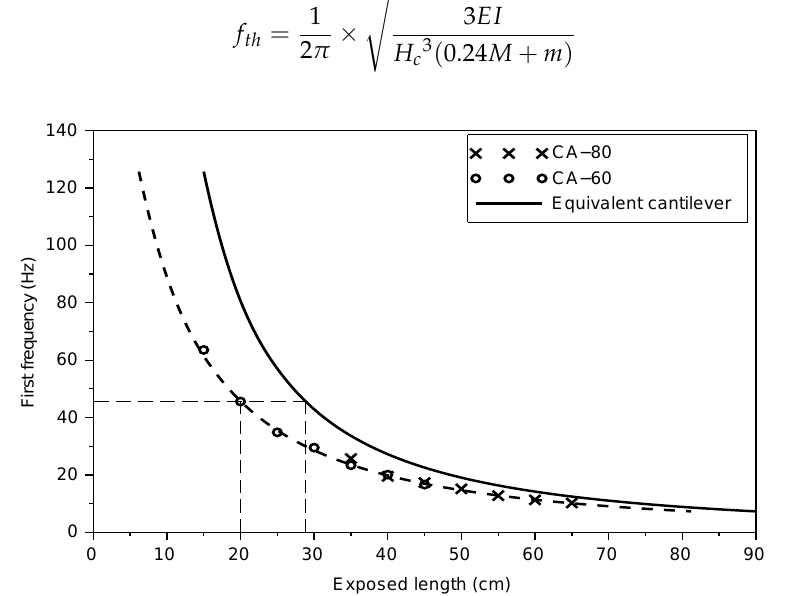
Figure 9. Equivalent cantilever of CA rod-sensors in sand: experimental first frequency for road-sensors CA-80 and CA-60, and first frequency of equivalent cantilever beam f th =